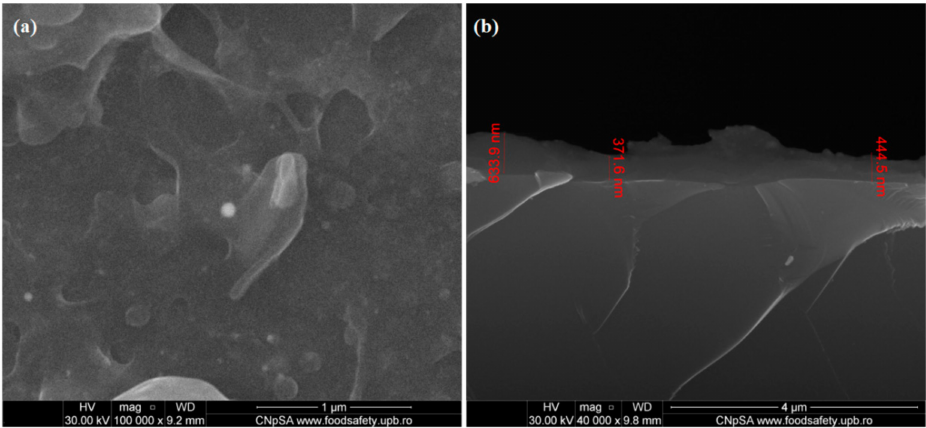
Figure 5. Plain view ( a ) and cross section ( b ) SEM images of PLA / AgNPs